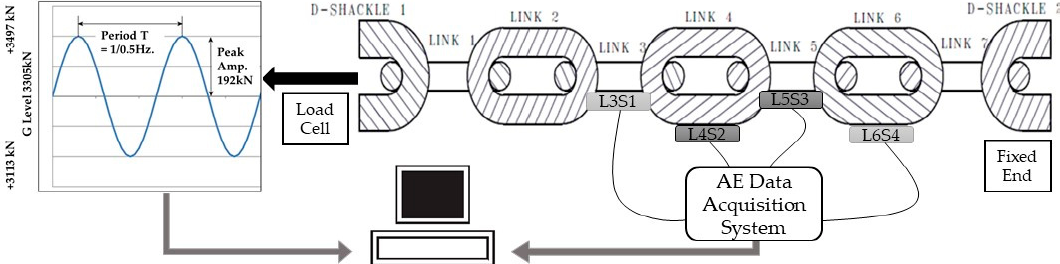
Figure 1. Test rig illustration: the chain is fixed at one end (right) and the loading (strain) is applied at the other end (left).